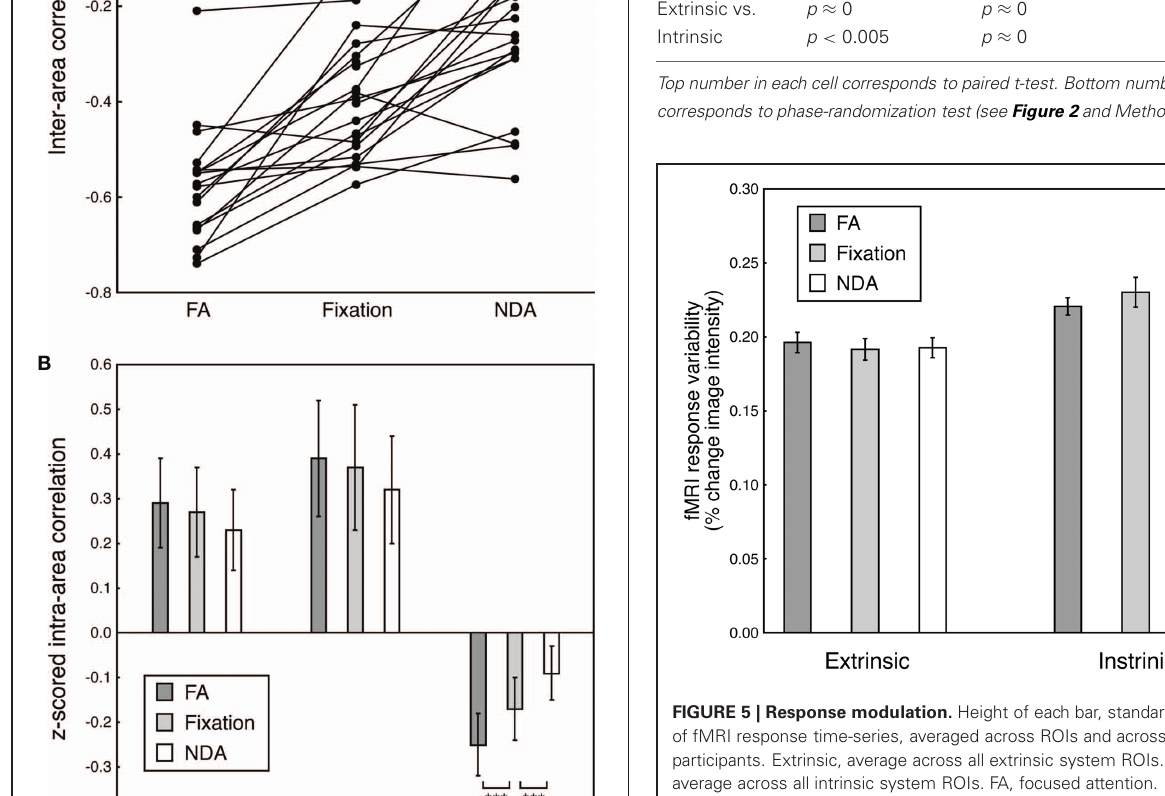
than in the extrinsic one, across all three conditions ( p < 0 .